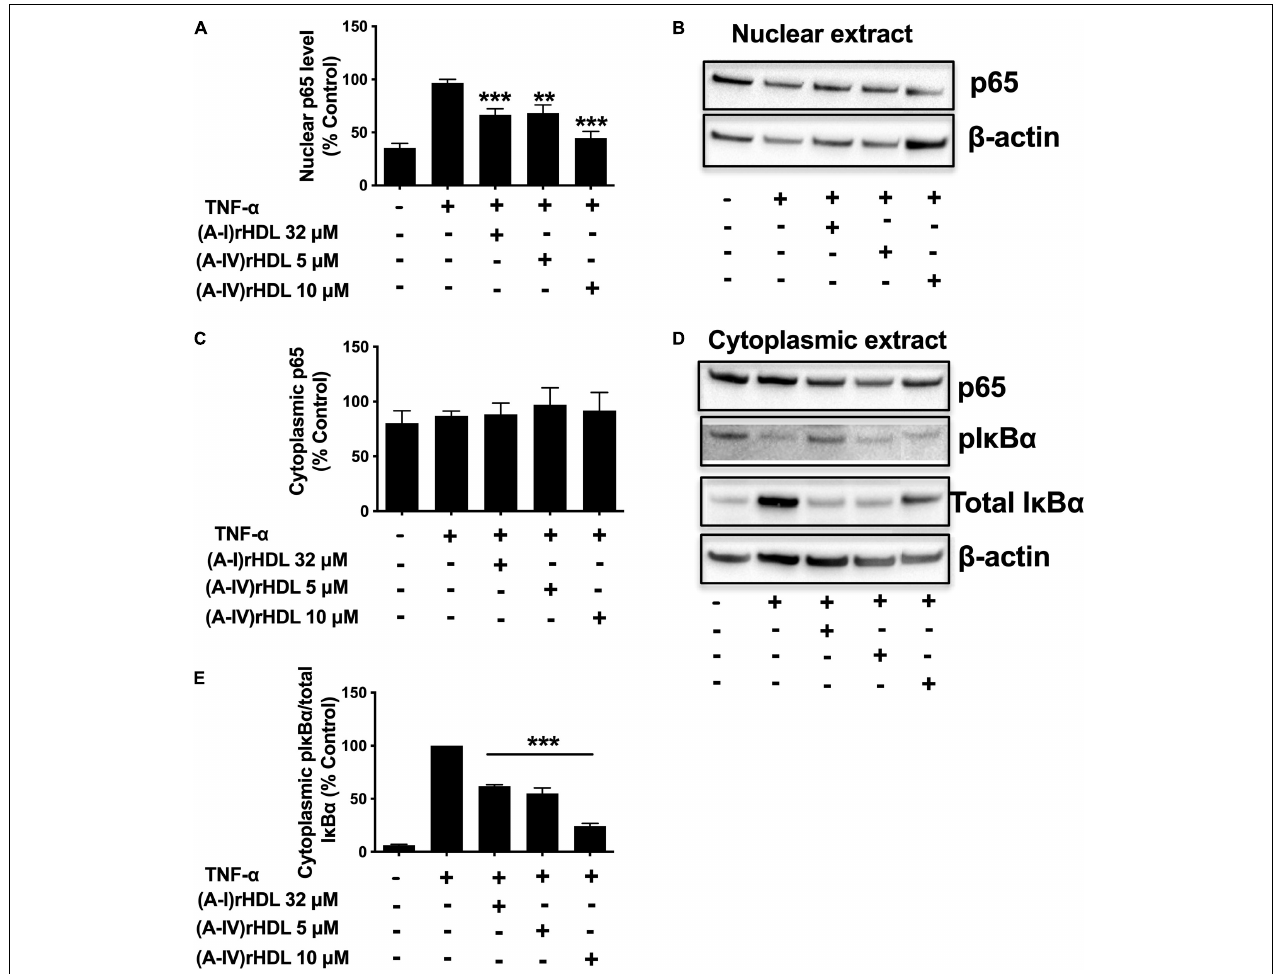
FIGURE 5 | (A-IV)rHDL inhibits NF- κ B activation in TNF- α -stimulated HCAECs. HCAECs were incubated for 16 h at 37 ◦ C with (A-I)rHDLs (final apoA-I concentration 32 µ M) or (A-IV)rHDLs (final A-IV concentration 5 and 10 µ M). The rHDLs were removed and the cells were incubated for 20 min at 37 ◦ C with TNF- α (0.2 ng/mL). Nuclear extracts were isolated and subjected to immunoblotting using β -actin as a loading control. Nuclear p65 protein levels (A,B) and cytoplasmic levels of p65 and phosphorylated I κ B α (pI κ B α ), (C,D) are shown. (E) Shows the ratio of cytoplasmic pI κ B α /I κ B α . Results represent mean ± SEM of three independent experiments, each performed in triplicate. ** p < 0.01, *** p < 0.001.